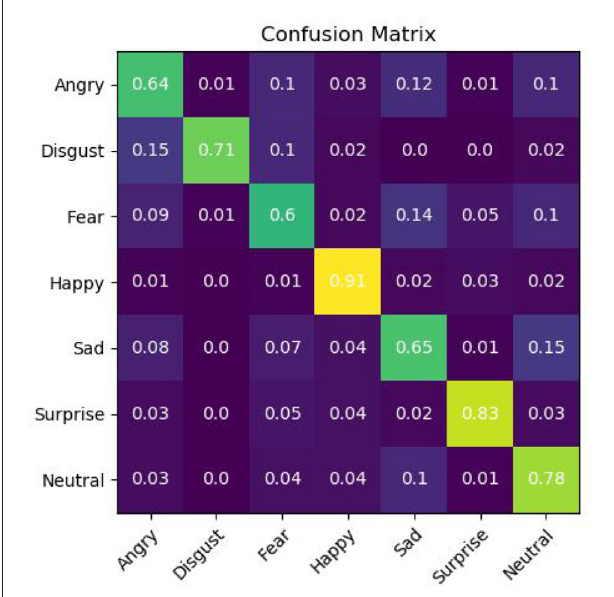
FIGURE 9 | Confusion matrix of MIFAD-Net on FER2013 testing